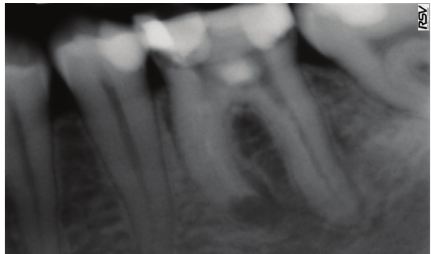
Figure 3: Radiograph at 2-month follow-up.